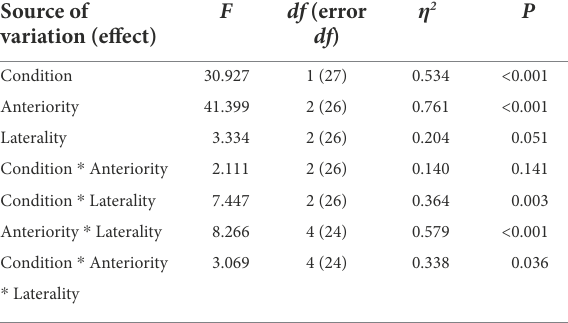
TABLE 3 Results of GLM repeated measures for the Go/NoGo